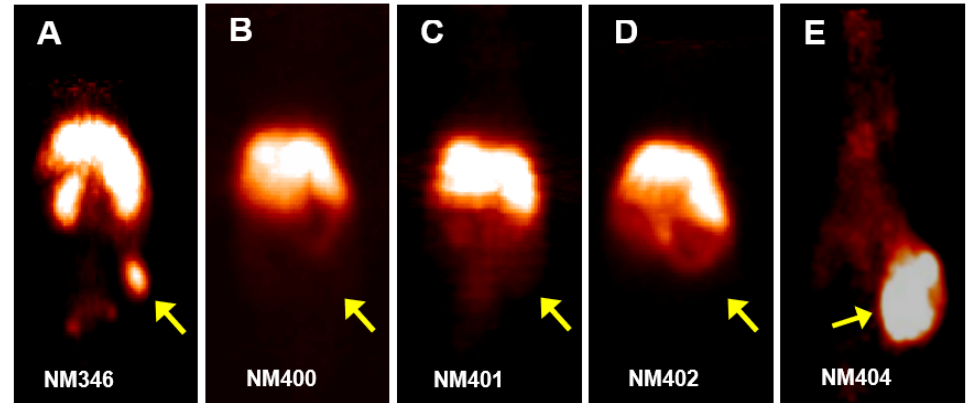
Figure 4. The 3D-microPET projection images obtained in human PC-3 prostate tumor-bearing mice 24 h after i.v. injection of iodine-124 labeled alkyl phospholipid polar head group analogs NM346 ( A ), NM400 ( B ), NM401 ( C ) and NM402 ( D ). Although NM404 is not a C12 analog, its image ( E ) is included for comparison. Tumor indicated by the arrow. Compared to NM346 which affords significant liver and gut activity as well as some tumor uptake, analogs NM400, NM401 and NM402 display similar liver and gut activity but no tumor uptake.